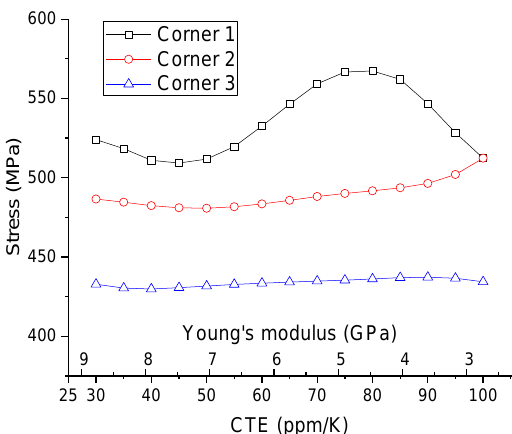
Figure 8. Effect of Young’s modulus on the von Mises stress at the critical locations for TSV Type A.